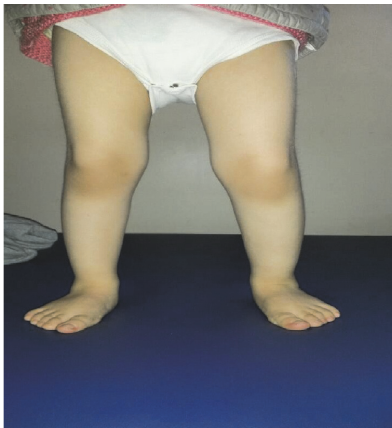
Figure 2: Her standing position (wide